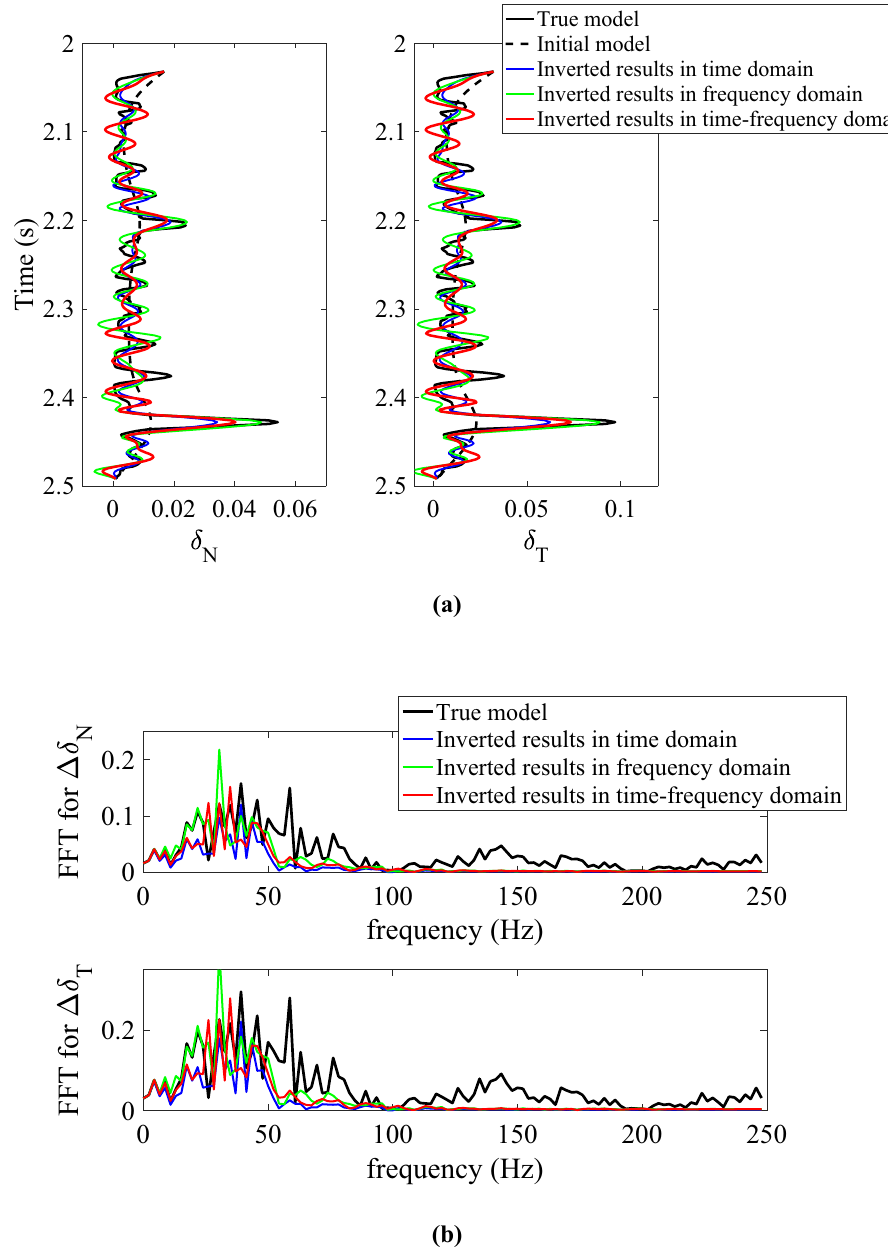
Figure 2. Comparison between original and inverted model parameters and spectra in time domain, frequency domain, and joint time–frequency domain with synthetic azimuth-dependent seismic data containing moderate noises (SNR = 5), where (a) is the inverted normal and shear fracture weaknesses in different domains, and (b) is the spectra comparison in different